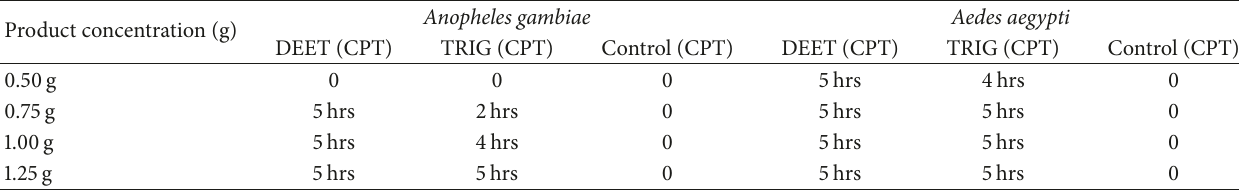
Table 2: Complete Protection Time (CPT) in hours for DEET and TRIG against mosquito bites in laboratory tests. Product concentration